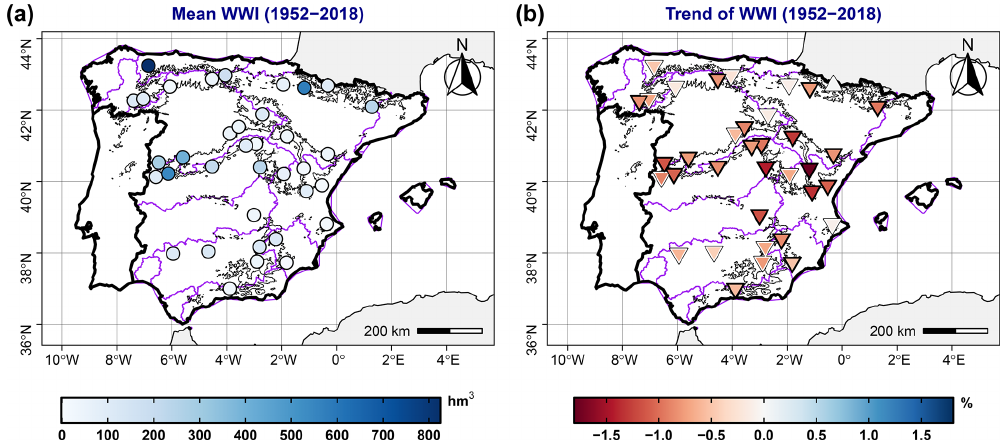
Figure 2. Panel (a) shows the mean WWI, and panel (b) presents the standardized Sen’s slope WWI trend estimates, computed as shown in Eq. (1) (Sect. 2.2). In panel (b) , upward-pointing triangles represent a positive trend, and downward-pointing triangles represent a negative trend. In panel (a) , significant estimates are indicated by a black outline. Contours of orography (black) and the IHBs of continental Spain (purple) are also shown (see Fig. 1).